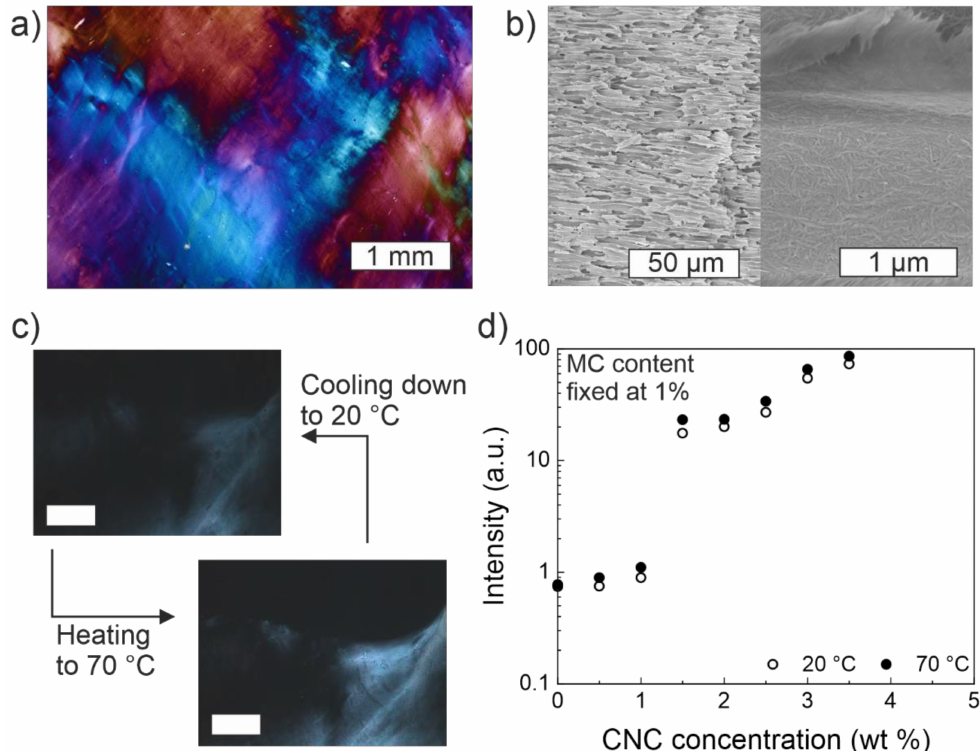
Figure 5. Birefringence in MC-CNC composite hydrogels. ( a ) MC-CNC 1–2.5% hydrogel imaged through crossed polarizers at 20 ◦ C. A full-wave plate is used for enhanced colors. ( b ) SEM micrographs of a MC-CNC hydrogel freeze-dried and fractured from 70 ◦ C at two different magnifications show CNCs dispersed in the MC medium. ( c ) The birefringence of MC-CNC gels intensifies upon heating to 70 ◦ C and recovers upon cooling down to 20 ◦ C. ( d ) Increase of birefringence intensity as a function of the hydrogels CNC content when MC is kept fixed at 1.0%. Note the logarithmic scale to highlight the differences also at the lower CNC loadings. Birefringence is visible above the intensity threshold of ~1. Adapted with permission from [31] (https://pubs.acs.org/doi/full/10.1021/acs.biomac.8b00392, date accessed on 3 September 2021). Copyright 2018 American Chemical